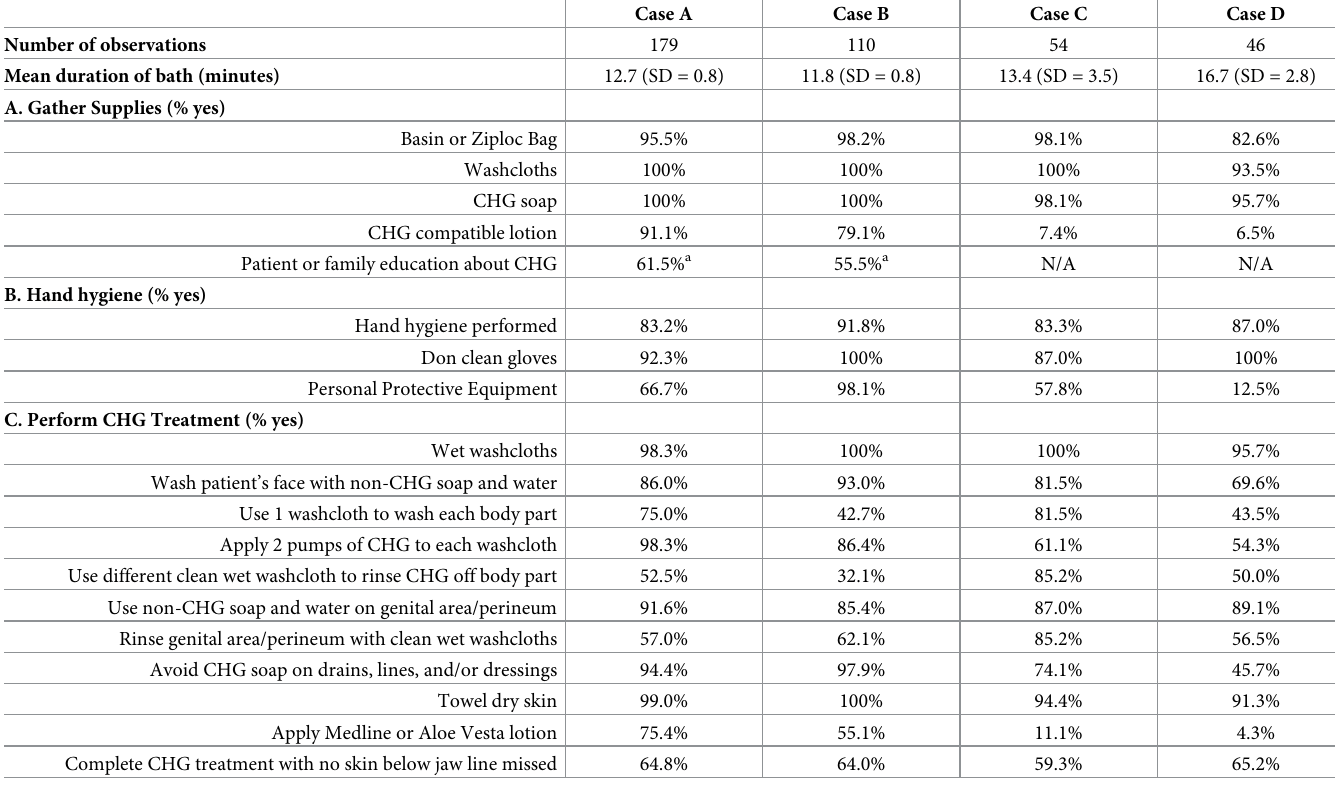
Table 2. Chlorhexidine treatment process compliance for the four cases (study